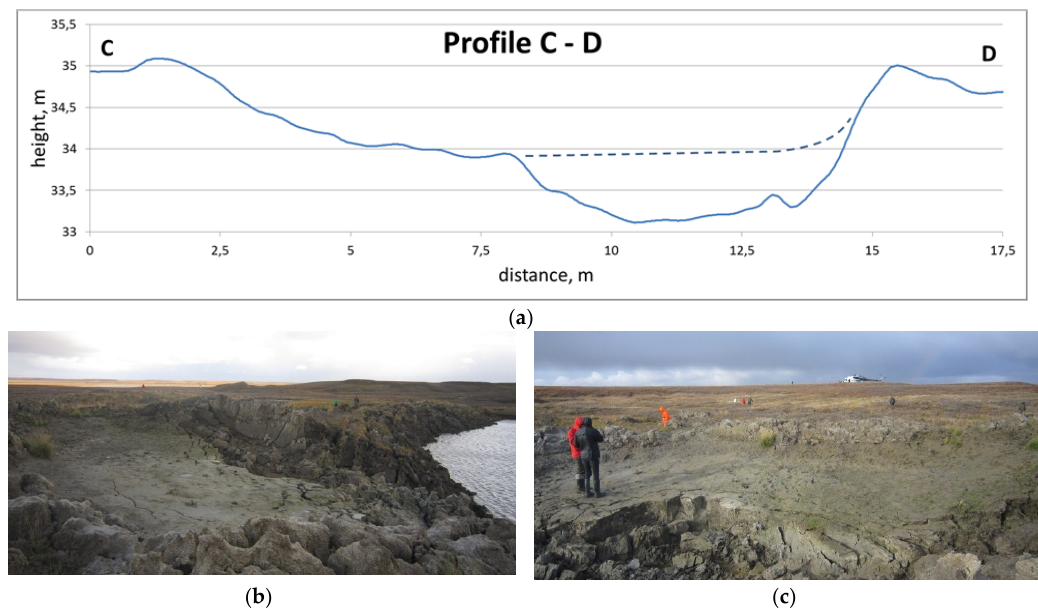
Figure 6. Morphological and morphometric characteristics of the impact hollow 10 at GEC-2. The location of the hollow and hypsometric profile are shown on Figure 10a: ( a ) hypsometric profile of the impact hollow 10 plotted on DEM 2017, dotted line refers to the reconstructed (before the start of erosion) bottom of the hollow; ( b ) and ( c ) hollow 10 drained by 2015 (photograph A. I. Kizyakov, September 2015).